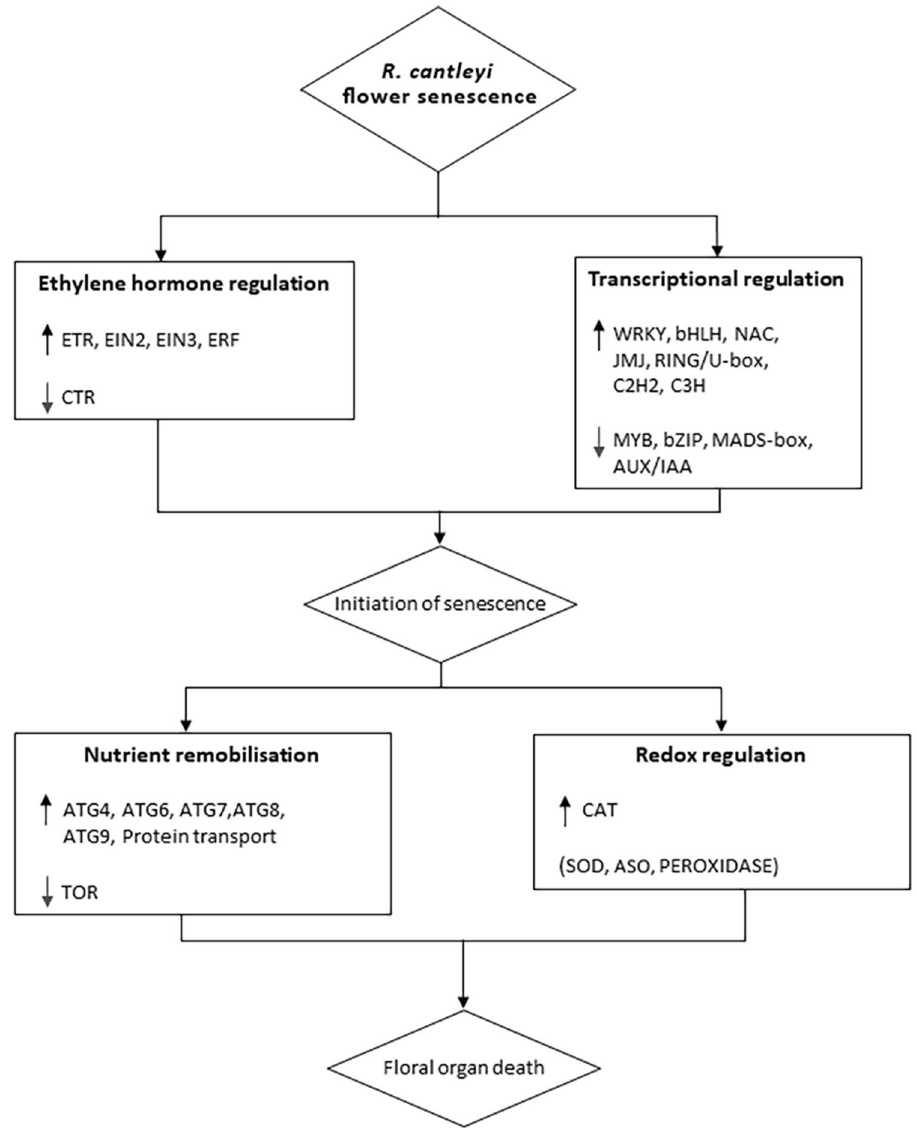
Figure 6. A model of flower senescence regulation in Rafflesia cantleyi . Upward arrows represent up-regulated genes and downward arrows represent down-regulated genes. Genes in parentheses are constitutively expressed. ASO L-ASCORBATE OXIDASE ; ATG AUTOPHAGY-RELATED GENES ; CAT CATALASE ; CTR CONSTITUTIVE TRIPLE RESPONSE ; EIN ETHYLENE-INSENSITIVE ; ERF ETHYLENE-RESPONSIVE TRANSCRIPTION FACTOR ; ETR ETHYLENE RECEPTOR ; SOD SUPEROXIDE DISMUTASE ; TOR TARGET OF RAPAMYCIN